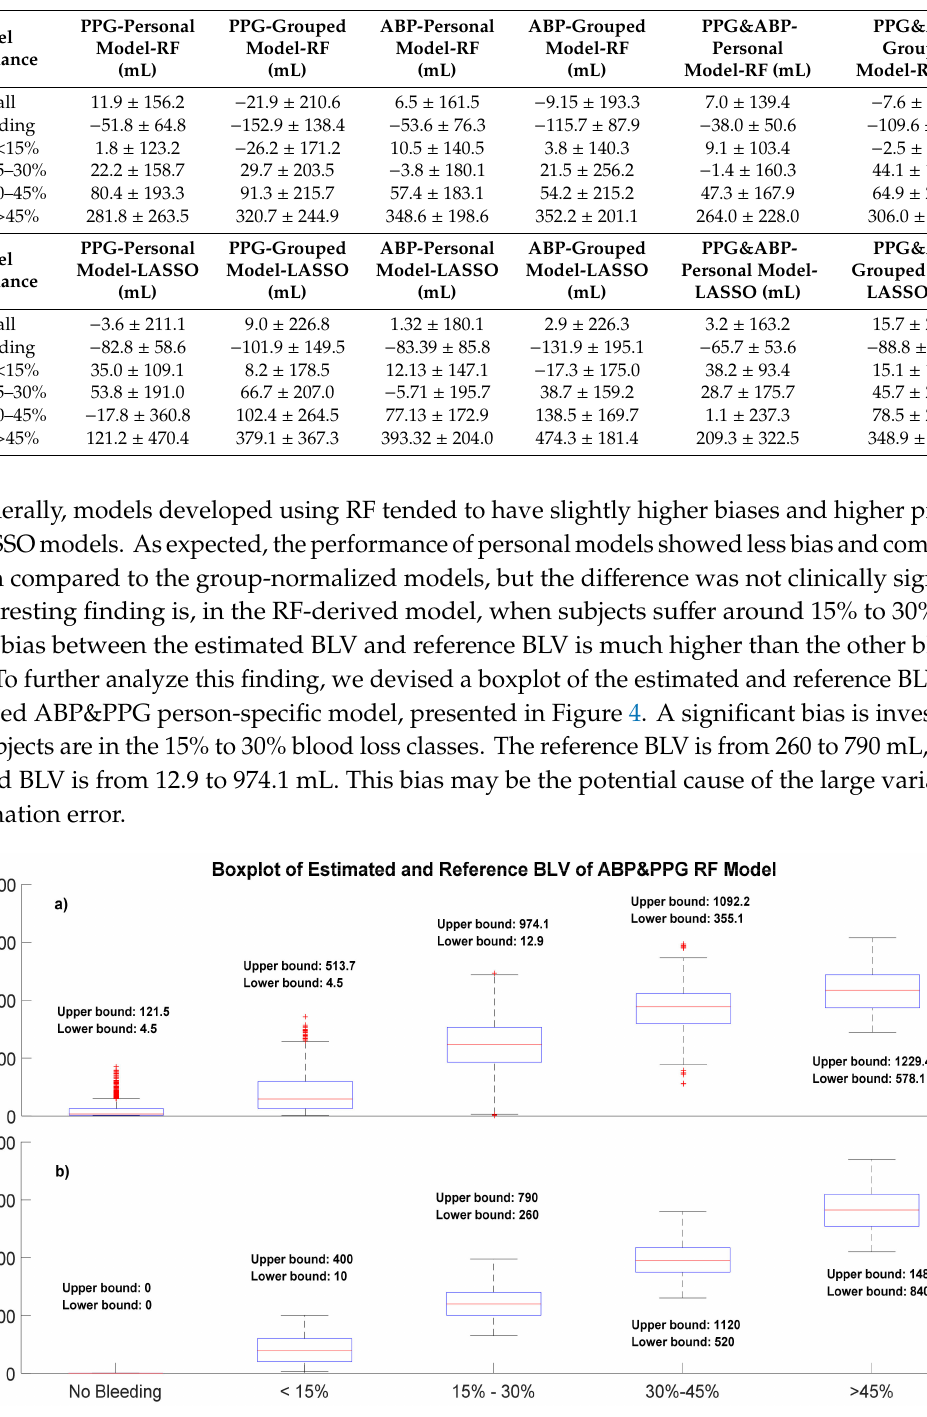
Figure 4. Boxplot of estimated and reference BLV of the RF-derived ABP&PPG person-specific model. ( a ) Estimated BLV; ( b ) reference